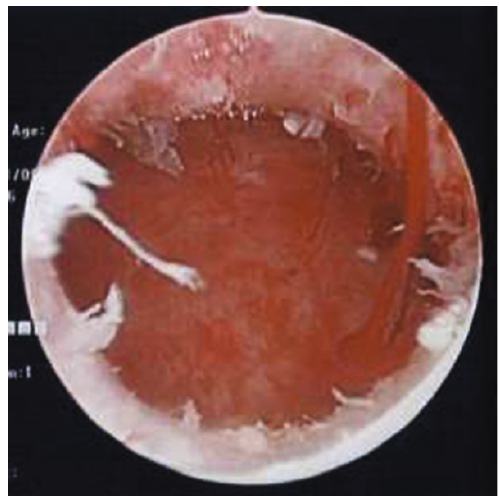
Figure 5: Hysteroscopic fi ndings. At the end of the surgery, the uterine cavity was